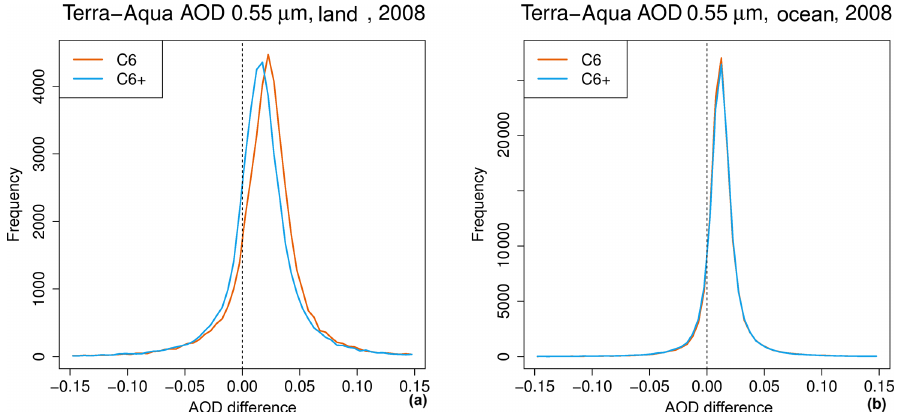
Figure 12. Histograms of the C6 + corrections on the Terra–Aqua AOD differences during 2008 over land (a) and ocean (b) . Histograms are derived from comparing gridded